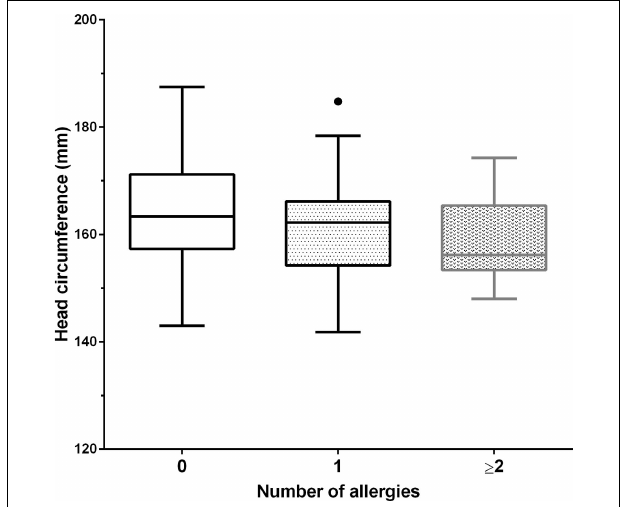
FIGURE 2 | Head circumference at mid-gestation vs. number of childhood allergies . Tukey boxplot, whereby “ (cid:15) ” represents a data point greater than the 75th percentile plus 1.5 times the interquartile range. 0 allergies ( N = 80), 1 allergy ( N = 30), (cid:21) 2 allergies ( N = 11). An inverse relationship was observed between mid-gestation head circumference and the number of childhood allergies ( p =